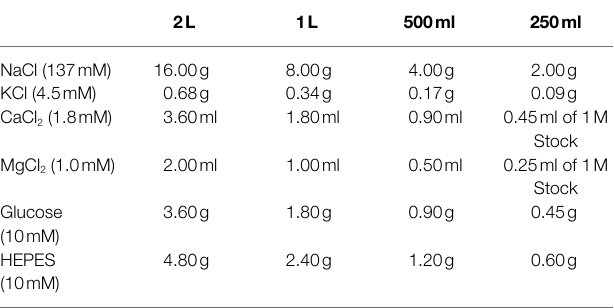
TABLE 1 | Dissection